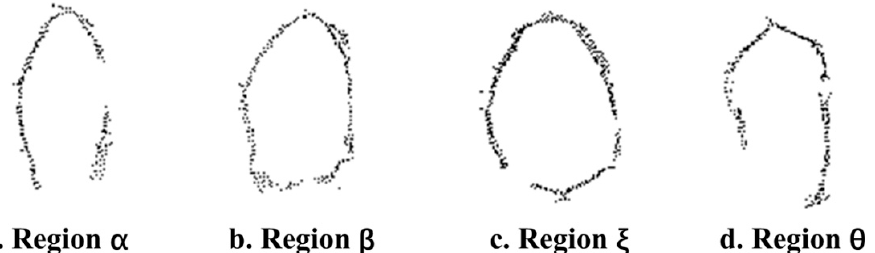
Figure 15. Extracted different key regions from beef cattle clouds.